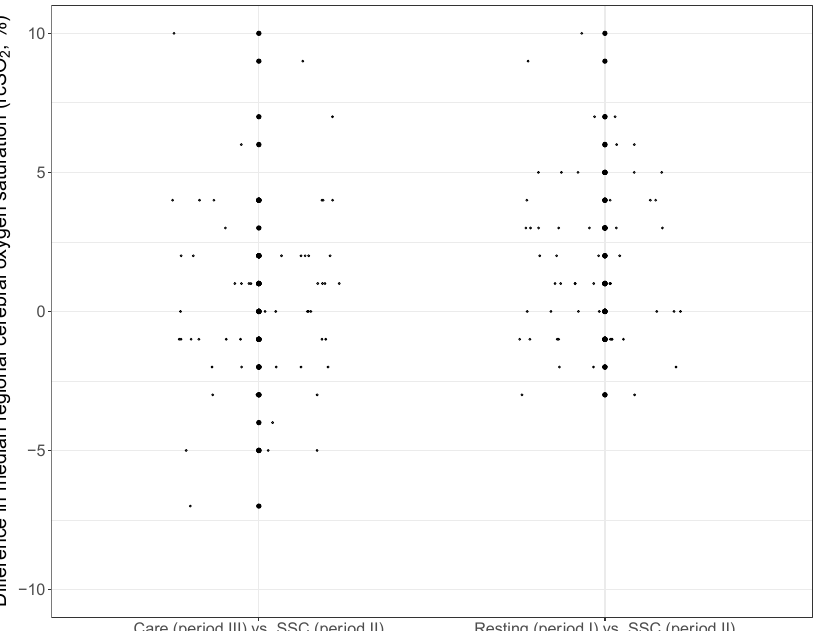
Figure 3. Intraindividual differences for all infants receiving SSC in the analysis of combined datasets (NIRS 1 and NIRS 2; n = 53). Values are based on the difference in the median of all measured values during the corresponding periods for each individual infant. Each small circle describes the difference of the infants between the period.